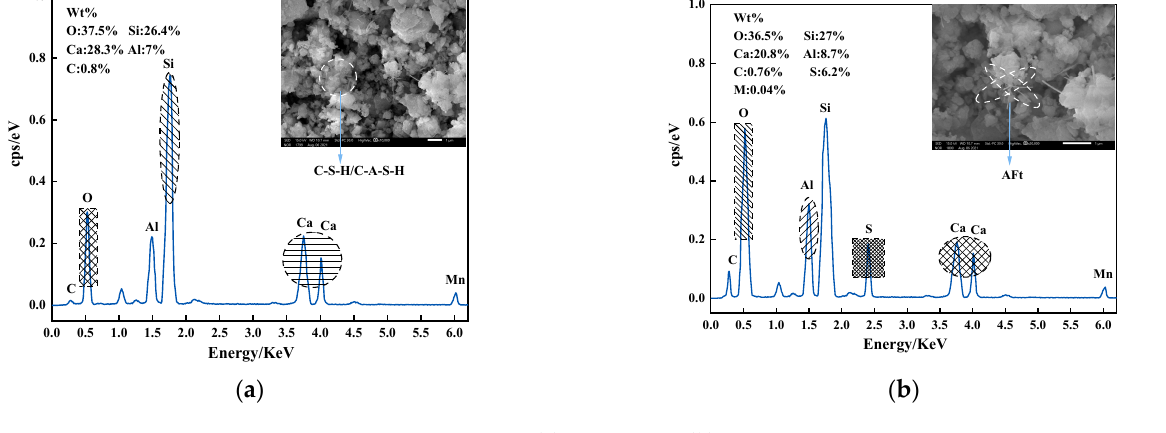
Figure 12. EDS images: ( a ) spectrum 1; ( b ) spectrum 2. Figure 11e,f show SEM images of different FCCR concentrations after ten w-d Figure 13 depicts a black-and-white binary image of the SEM processed with Image- Pro Plus, revealing which part of the soil has porosity. In the test block, porosity is defined as the ratio of the pore volume (area of the white zone in the black and white binary image) to the volume of the material (area of the black zone in the black and white binary image).